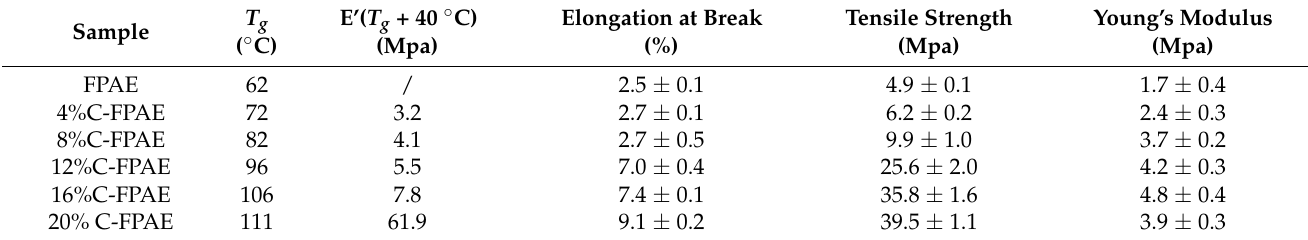
Figure 4. Mechanical properties of FPAE and C-FPAE series with different BDB contents: ( a ) stress – strain curve,( b ) mechanical properties of the x% C-FPAE series with different cross-linker contents. Table 2. Mechanical and thermal properties of FPAE and C-FPAE with different BDB contents.